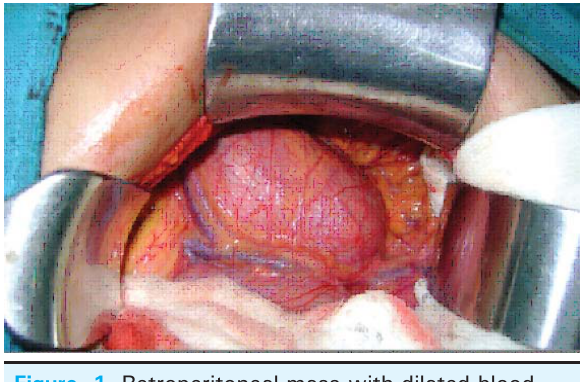
Figure 1. Retroperitoneal mass with dilated blood vessels It was free from surrounding solid organs and great